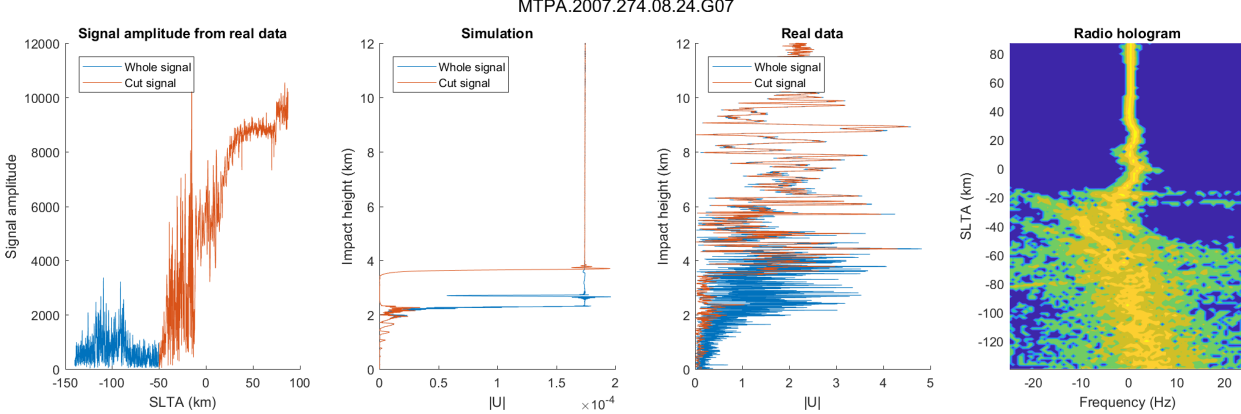
Figure 11. An event classified as category 3. SLTA min is at approximately − 99km, and the signal is truncated at SLTA = − 50km. The reflection spike is located at an impact height of 2363m, and a min is 2301m.